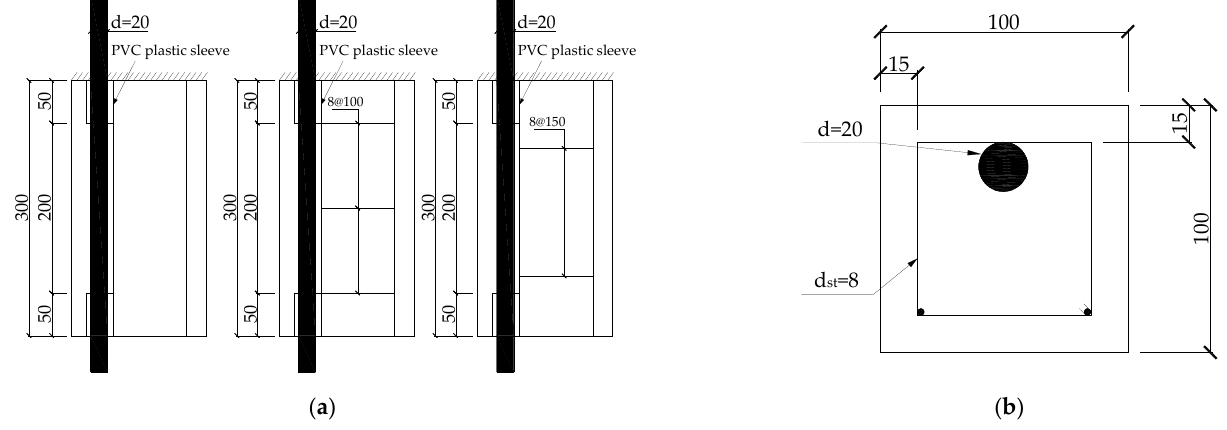
Figure 1. Test specimen (mm): ( a ) Different stirrup arrangement; ( b ) Cross-section